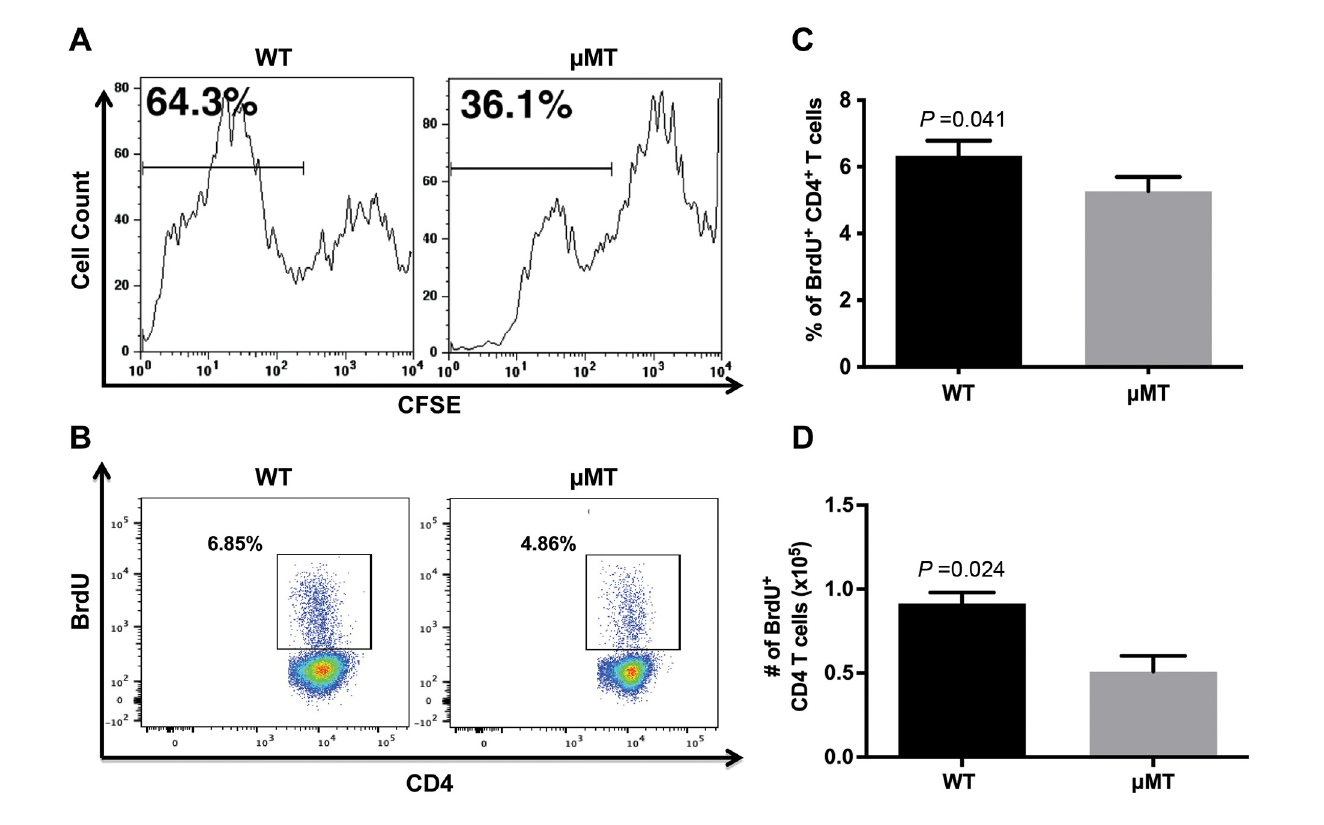
Fig 2. The presence of B cells promotes cellular expansion and CD4 + T cell proliferation in the lung of mice with chronic TB. WT and μ MT mice were infected with 100 CFU M . tuberculosis Erdman delivered via aerosolization. Dilution of CFSE by ex vivo lung cultures taken 5 months after infection. Cells from 3 mice per group were pooled for the analysis. Data in (B and C) show the frequencies of BrdU + CD4 + T cells in the lungs of WT and μ MT mice derived from in vivo BrdU labeling studies conducted at 5 months post-infection. The data shown in (B) depicts a representative dot plot targeting BrdU + CD4 + T cells. Results shown in (C) are mean ± SEM of the frequencies of BrdU + CD4 + T cells. Three to 4 mice per group were evaluated. (D) The absolute number of lung BrdU + CD4 + T cells at 5 months after infection upon in vivo BrdU labeling. The data shown depict mean ± SEM of 3 to 4 mice per group. Data shown are representative of 2 to 3 experiments, except for that in (A), which are derived from 1